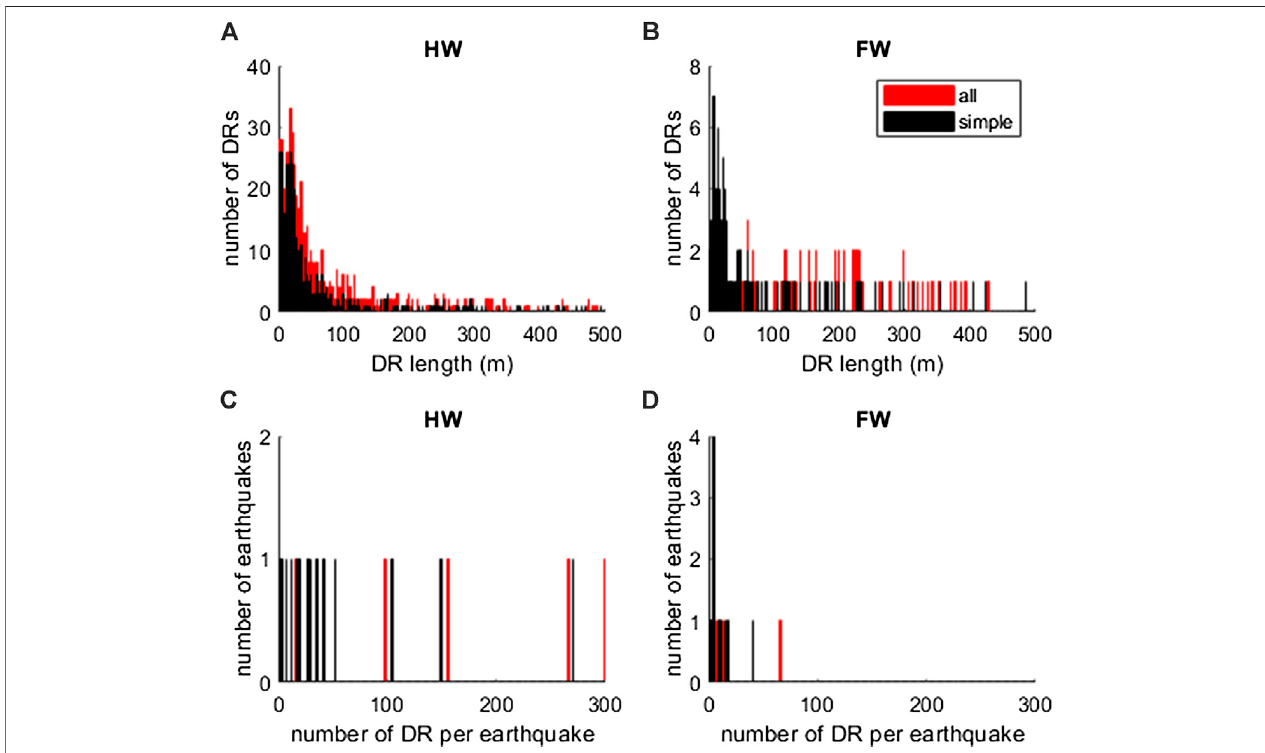
FIGURE2| Numberofdistributed ruptures andassociatedDRlengths onhangingwall (A) andfootwall (B) sides.ForthesakeofreadabilitytheDR lengthsshown inhistogramarecutin fi rst500 moflength,themaximumDRlengthbeing3,665 monhangingwall,andonfootwall1,480 mwhenconsideringonlysimpletypeDR,and 2,156 m when considering all types of DR. The graphs below show the number of DRs per earthquake on hanging wall (C) and footwall (D) . All types of DR plotted on red, simple types of DR (only ranking 2) being a subset of “ all ” plotted on black.